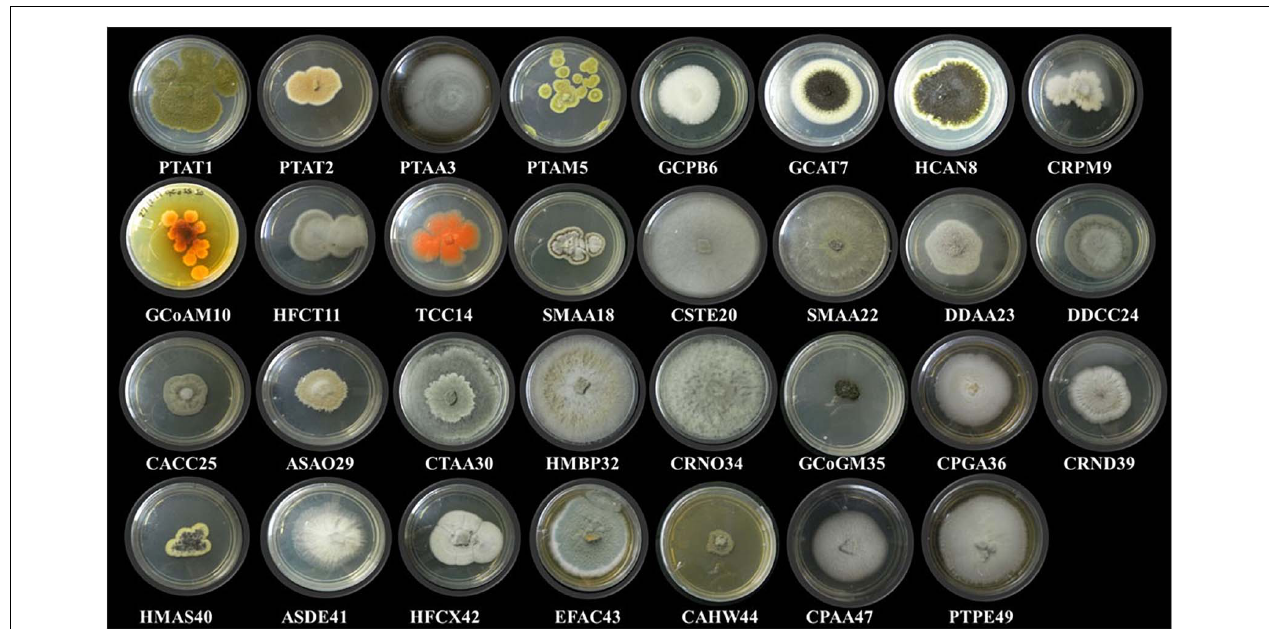
FIGURE 1 | Different endophytic fungi (morpho species) isolated from marine brown, green, and red